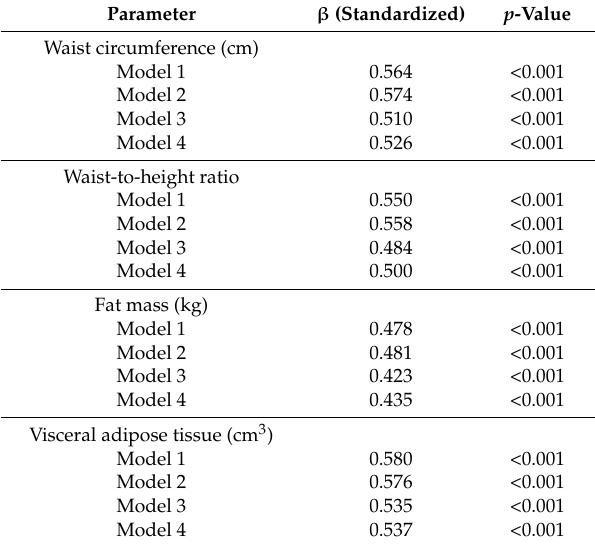
Table 2. Associations between anthropometrics and body composition parameters and the controlled attenuation parameter in youths with